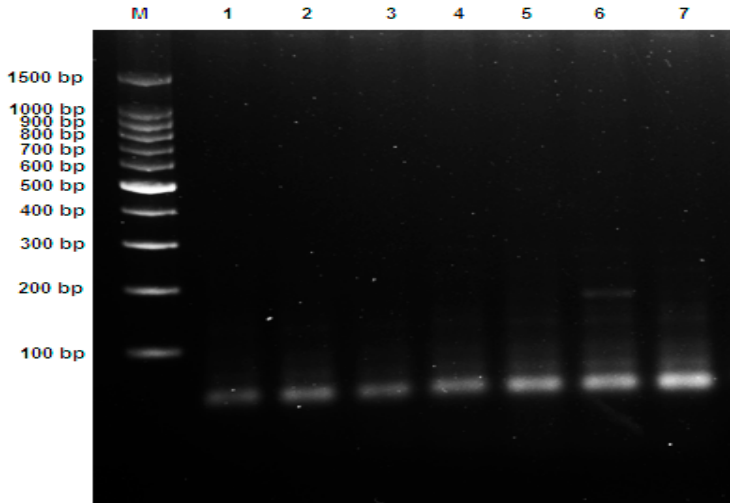
Figure 4. Ethidium bromide-stained 1.5% agarose gel with multiplex PCR products showed C. bot- ulinum neurotoxin genes from eight bacterial samples isolated from the Beheira governorate (lanes 1–8), where M represents a 1500 bp DNA ladder.